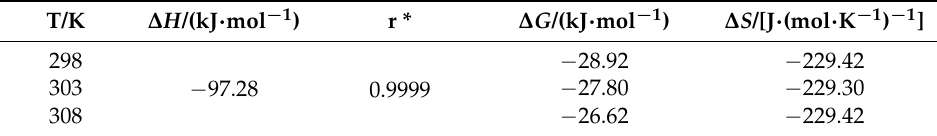
Table 5. Thermodynamic parameters of the lysozyme–tannic acid system at 298, 303, and 308